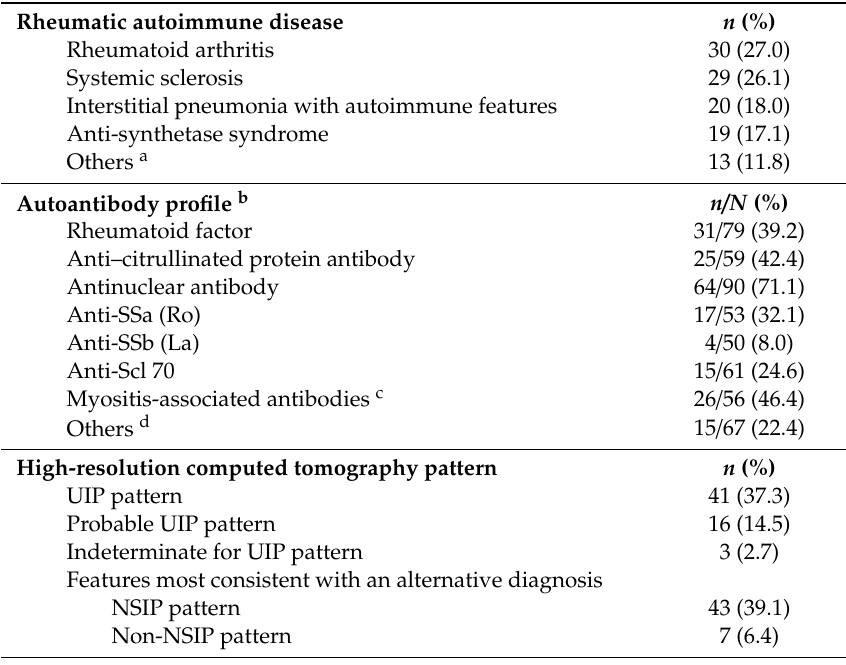
Table 2. Spectrum of the 111 AD-ILD patients included in the study.